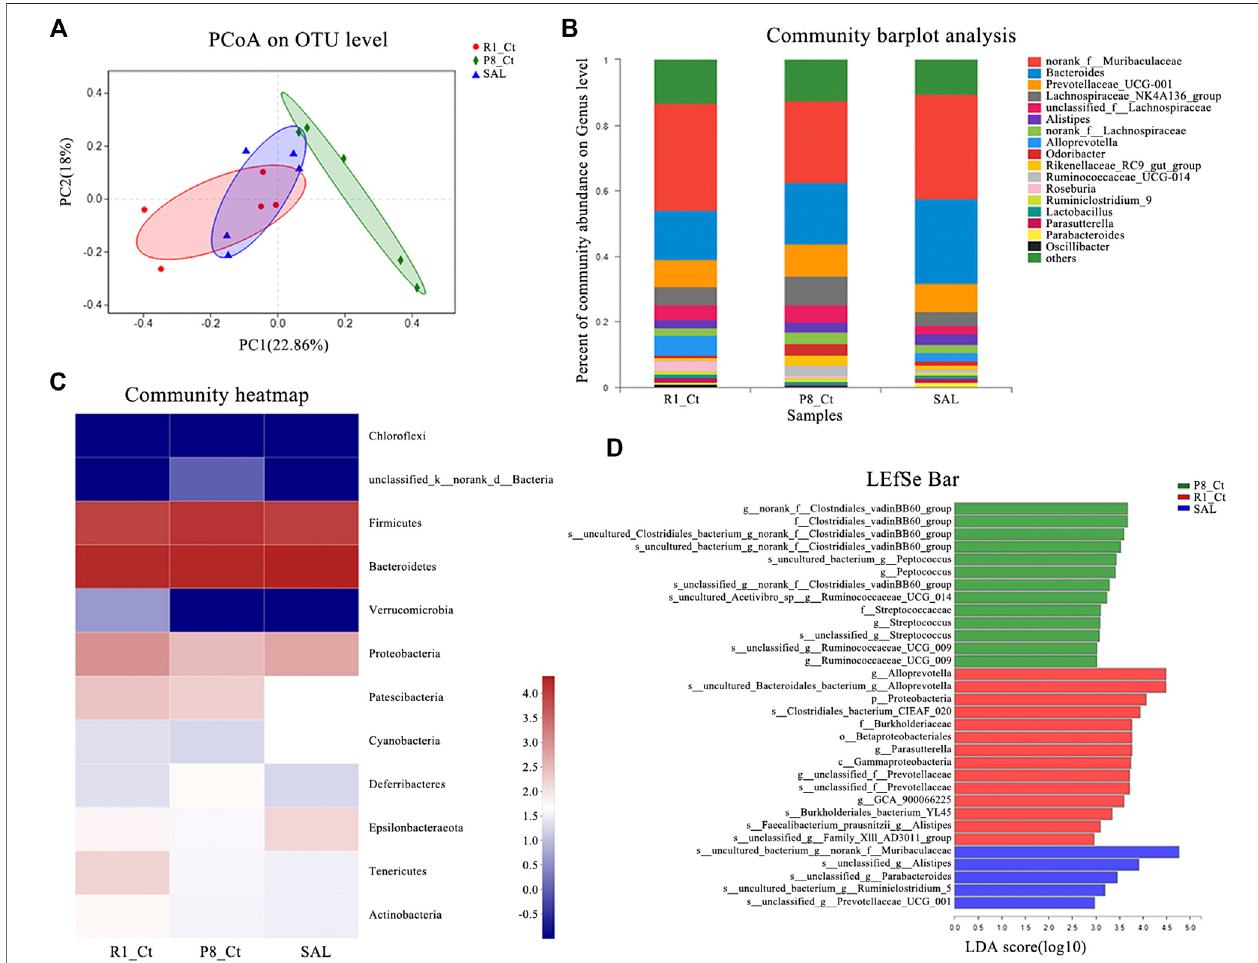
FIGURE6| EffectofSALonthegutmicrobiotainSAMP8mice. (A) PCoAplotsoftheBray-Curtisdistanceattheoperationaltaxonomicunit(OTU)level. (B) Barplot analysis of the relative abundance in the community at the genus level. Genera with abundances less than 0.01 (1%) are summed in the category “ others ” . (C) Heatmap of microbial community abundance pro fi les at the phylum level. Top 50 species by total abundance. (D) Results of the LEfSe analysis (LDA > 2) at the phylum to the species level.